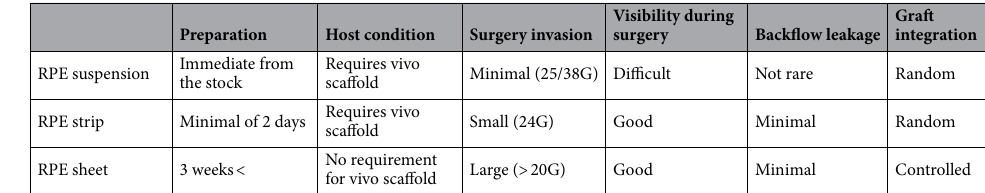
Table 1. Comparison of RPE transplantation strategies: cell suspension vs. strip vs.